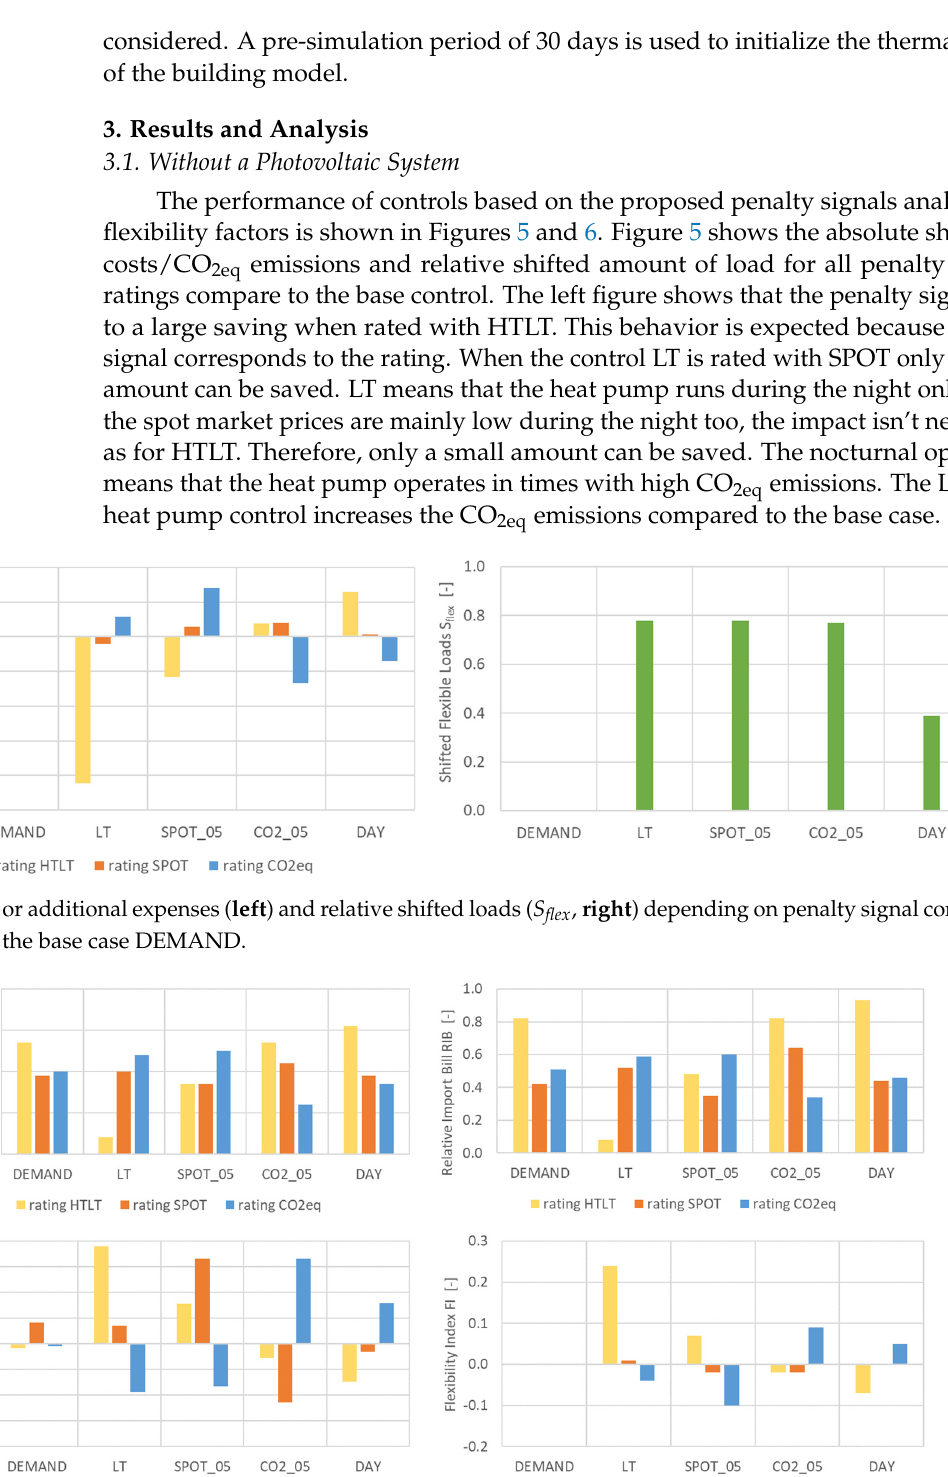
Figure 4. Example for the penalty signal SPOT_05.